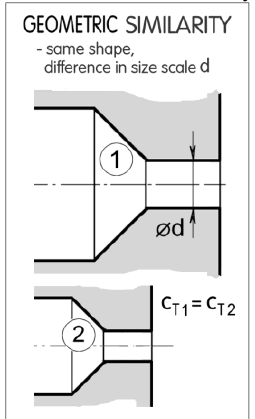
Fig. 5. Two nozzles are fully similar if they differ only in magnitude of the exit diameter d . Such full similarity has been always considered a necessary condition for application of the dimensional